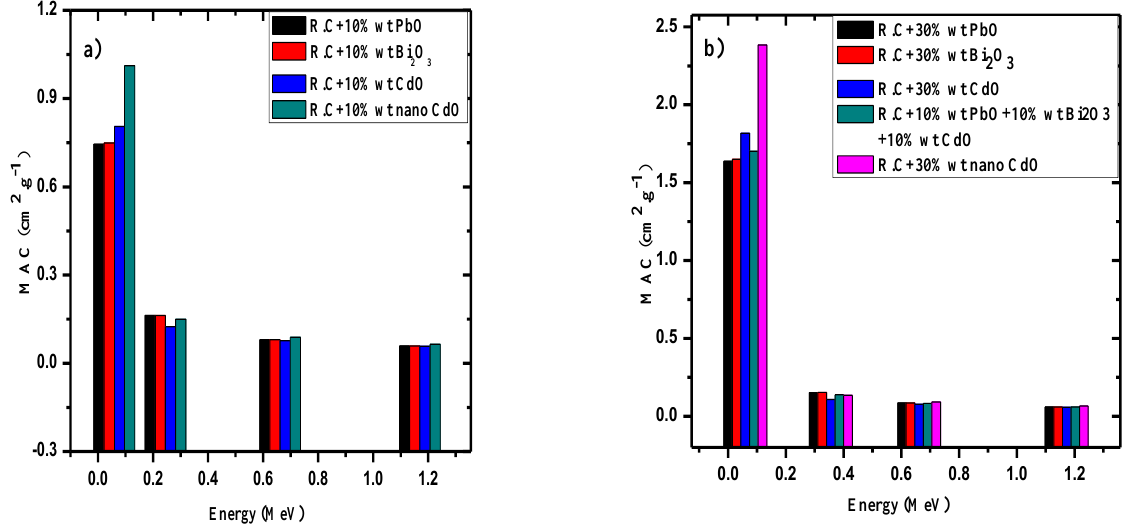
Figure 6. ( a,b ) The MAC for red clay filled with 10 wt% of different micro-oxides and 10 wt% CdO nanoparticles. Finally, the present ceramic samples based on red clay were compared with two other materials used as a shielding material in nuclear facilities (concrete [40], and white ceramic [41]) as shown in Figure 7, where the HVL values were 4.581; 4.582; 3.175; 3.049; 3.525; 3.526; and 3.001 (cm) for concrete; white ceramic; R.C with 30wt% PbO; R.C with 30wt% Bi 2 O 3 ; R.C with 30wt% bulk CdO; R.C with 10wt% PbO, 10wt% Bi 2 O 3 and 10wt% CdO; and R.C with 30wt% nano-CdO, respectively. The results indicated that the present ceramic-materials-based red clay has good radiation-shielding features.